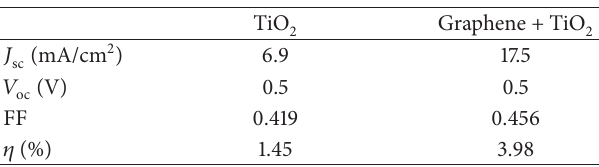
Figure 4: Energy level diagram and mechanism of photocurrent generation in the DSSCs with the graphene electron transfer layer. DSSCs with and without graphene Table 1: The parameters for TiO 2 electron transport